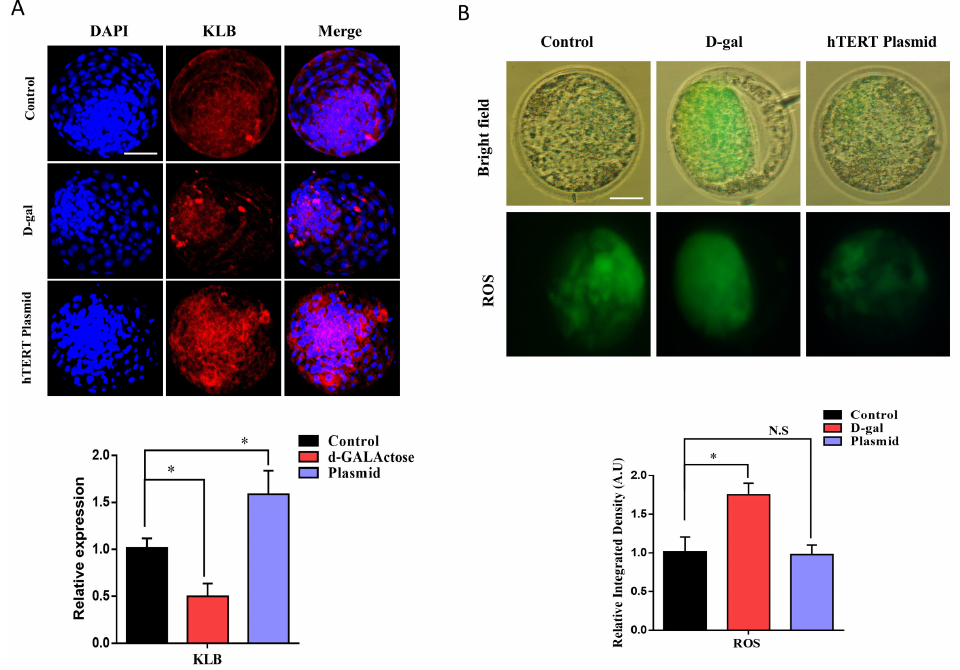
Figure 3. TERT plasmid injection enhances KLB protein expression and inhibits ROS level. ( A ) Im- munofluorescent expression of KLB in bovine day-8 blastocysts treated with control, D-galactose, and TERT plasmid. ( B ) Reactive oxygen species (ROS) level was measured via H2DCFA staining in bovine day-8 blastocysts. The result showed a significant reduction in ROS level with hTERT plasmid injection. The data shown here as a mean ± S.E.M. N.S, not significant, * = p < 0.05, and Bar = 100 µ